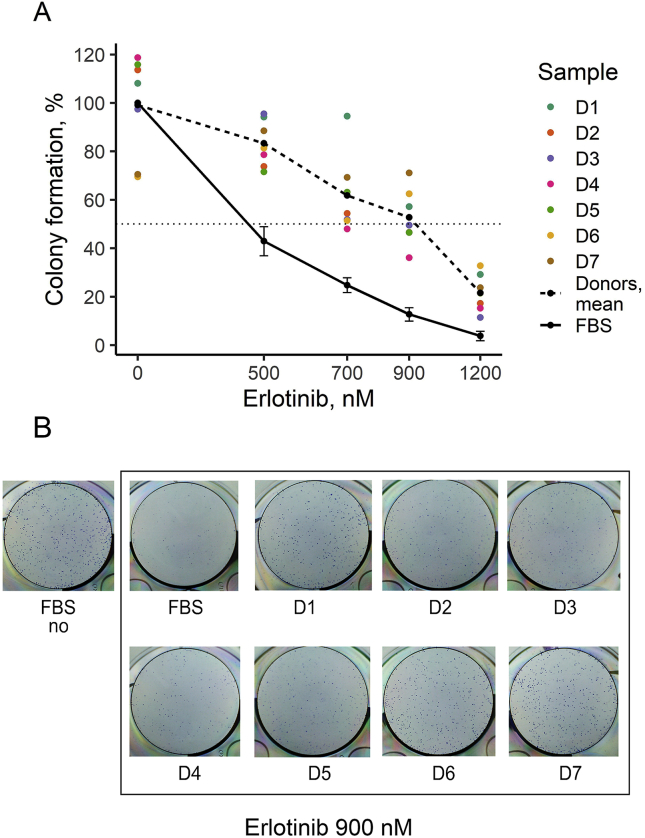
(A) A431 relative clonogenicity after treatment with erlotinib in the presence of human donor serum samples. Colored points represent average clonogenicity for each donor sample calculated from three replicates, D1-7 denotes the donor ID. The solid line (FBS) defines clonogenicity in the presence of FBS only; dotted line (mean) defines clonogenicity averaged for seven human donor samples. Colony formation is normalized to the results of the experiments with FBS-only growth media. (B) Representative photographs of stained clonogenicity assay wells, which were used for colony number calculations for 900 nM erlotinib - treated cells.